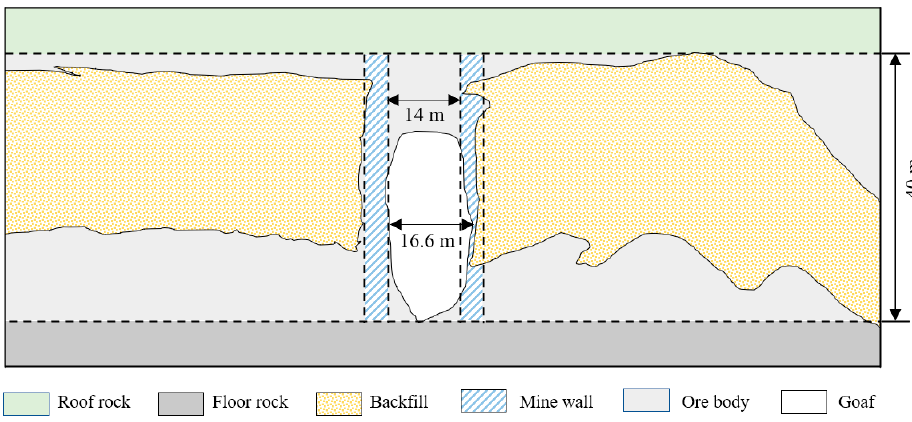
Figure 8. Vertical cross section view of empty area scan results.